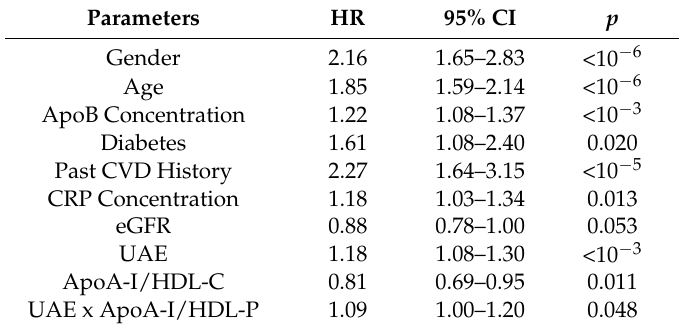
Table 7. Risk model results of second screening round examining interaction of UAE with apoA-I/HDL-C with adjustments for gender, age, apoB, diabetes, past CVD history, CRP, and eGFR. Hazard ratios are per SD unit for continuous variables. Parameters HR 95% CI p Gender 2.16 1.65–2.83 <10 − 6 Age 1.85 1.59–2.14 <10 − 6 ApoB Concentration 1.22 1.08–1.37 <10 − 3 Diabetes 1.61 1.08–2.40 0.020 Past CVD History 2.27 1.64–3.15 <10 − 5 CRP Concentration 1.18 1.03–1.34 0.013 eGFR 0.88 0.78–1.00 0.053 UAE 1.18 1.08–1.30 <10 − 3 ApoA-I/HDL-C 0.81 0.69–0.95 0.011 UAE x ApoA-I/HDL-P 1.09 1.00–1.20